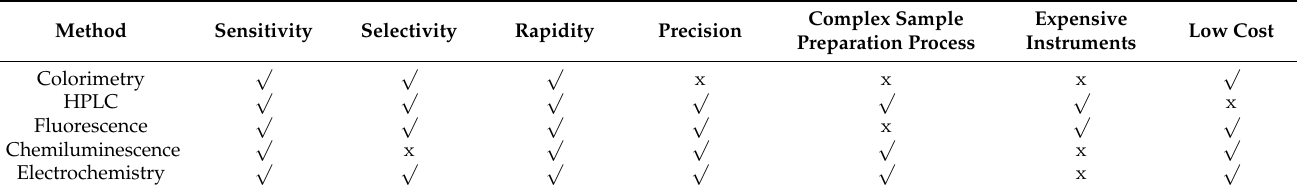
Table 1. Comparisons of different methods for UA